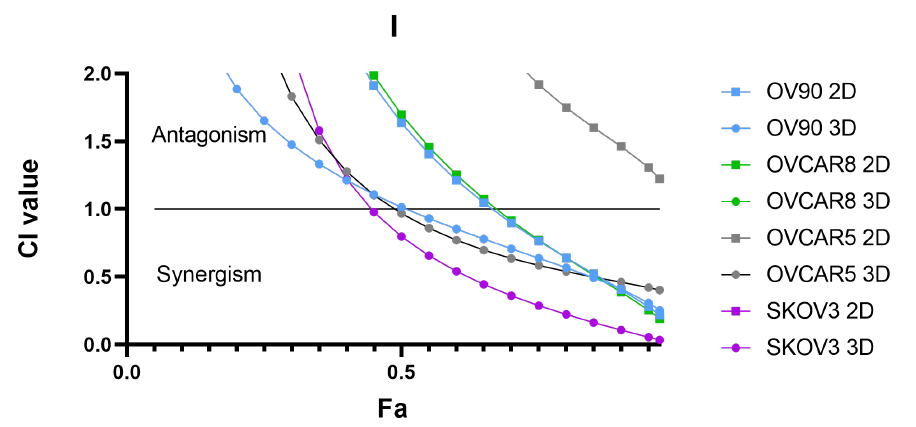
Figure 3. The effect of the combination of BEZ235 and SCH772984 at 1/4, 1/2, 1, 2 and 4 × EC 50 on cell proliferation in OV-90 ( A , B ), OVCAR8 ( C , D ), OVCAR5 ( E , F ) and SKOV3 ( G , H ) monolayer and aggregate cultures. Due to an unobtainable EC 50 value (1322.37 µ M) for SCH772984 in SKOV3 aggregates the concentration used is based off OVCAR5 aggregates, which also had a high EC 50 value (46.1 µ M). Concentrations have been rounded for brevity. A significant decrease in proliferation was seen in OV-90, OVCAR8 and OVCAR5 monolayers and in OV-90, OVCAR8, OVCAR5 and SKOV3 aggregates. CI values indicate a synergistic interaction in OV-90 and OVCAR8 monolayers and OV-90, OVCAR5 and SKOV3 3D aggregates ( I ). CI values for SKOV3 monolayers and OVCAR8 3D aggregates do not appear in the figure as these exceeded the range of values used, which indicates a strongly antagonistic effect. Data are expressed as mean ± SEM (n = 4). Statistical significance is at p < 0.05 and is in comparison to the control. The statistically significant differences are indicated as p < 0.05 (*), p < 0.01 (**) and p < 0.0001 (****), as determined by one-way ANOVA with